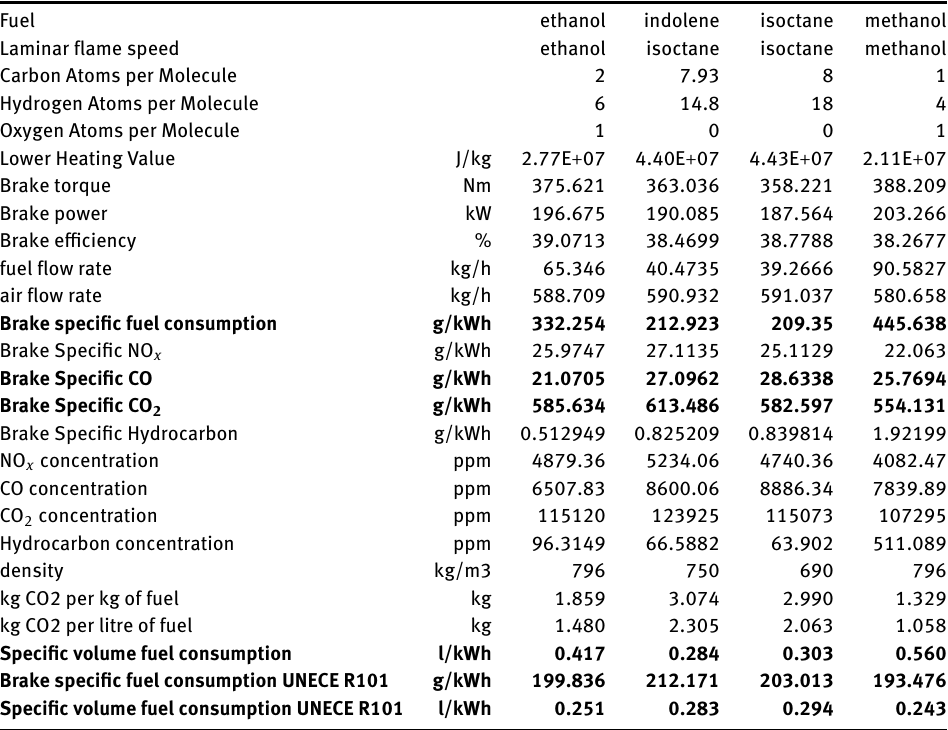
Table 2: Simulation of a turbo charged, directly injected, spark ignition engine fuelled with ethanol, methanol, isoctane and indolene. Fuel